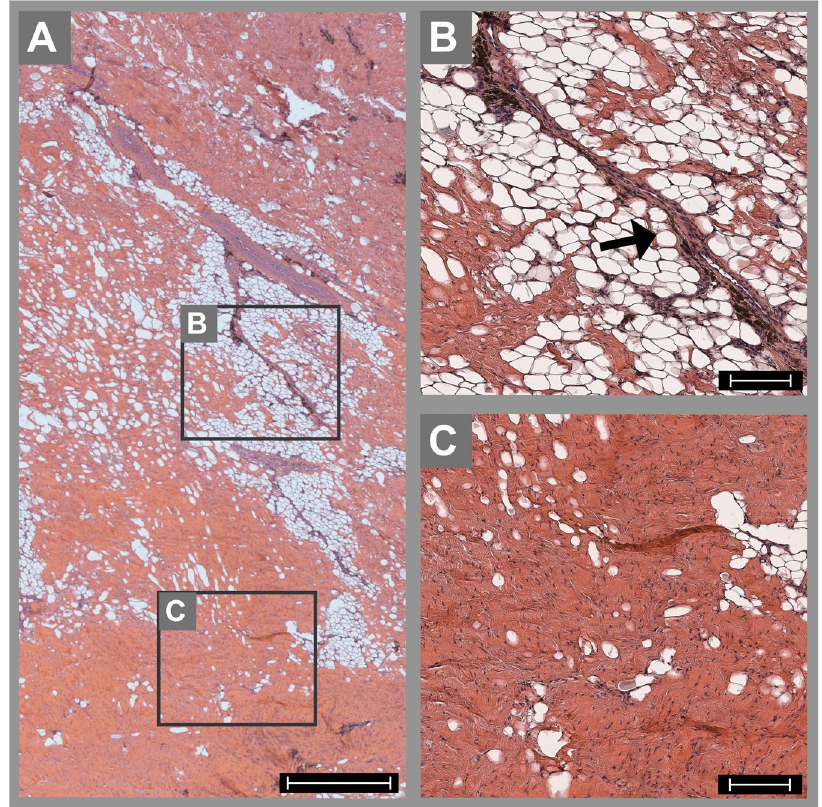
Fig. 6 Histological specimen of the soft tissue from the forehead covering a subperiosteal NiTi implant after 16 weeks stained with hematoxylin – eosin. The tissue is mainly characterized by fat and some connective tissue (arrow in B ) and striated muscle ( C ). No relevant signs of acute or chronic in fl ammation are observed. The black boxes in A indicate the magni fi ed areas in B and C . The scale bar is 1000 µm